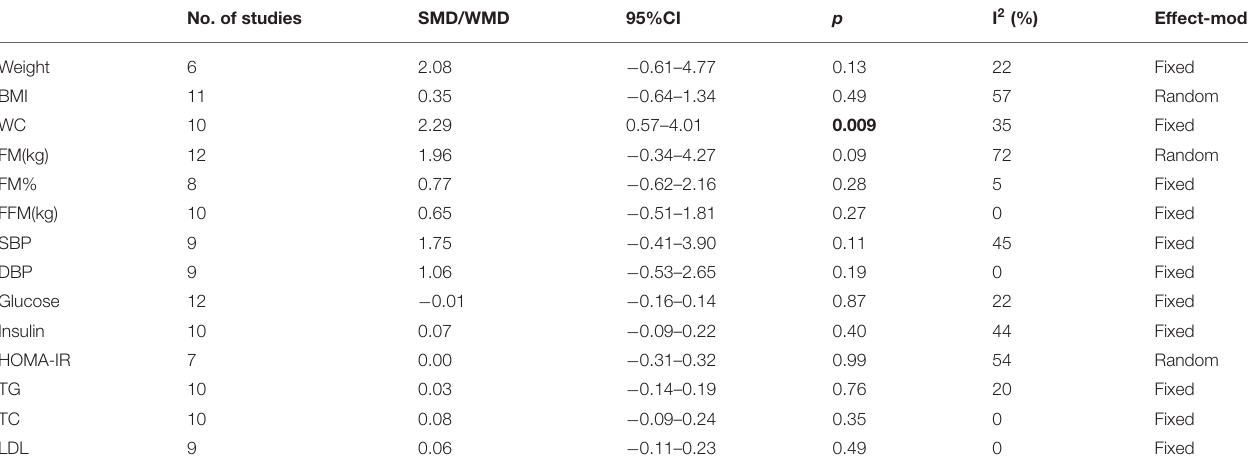
TABLE 2 | Physical and biochemical parameters of IF vs.